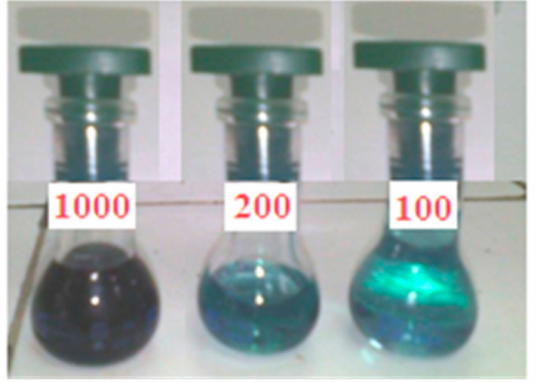
Figure 6. Color of complex at different concentrations (100 mg · L − 1 ~1.6 × 10 − 4 M; 200 mg · L − 1 ~ 3.2 × 10 − 4 M; 1000 mg · L − 1 ~1.6 × 10 − 3